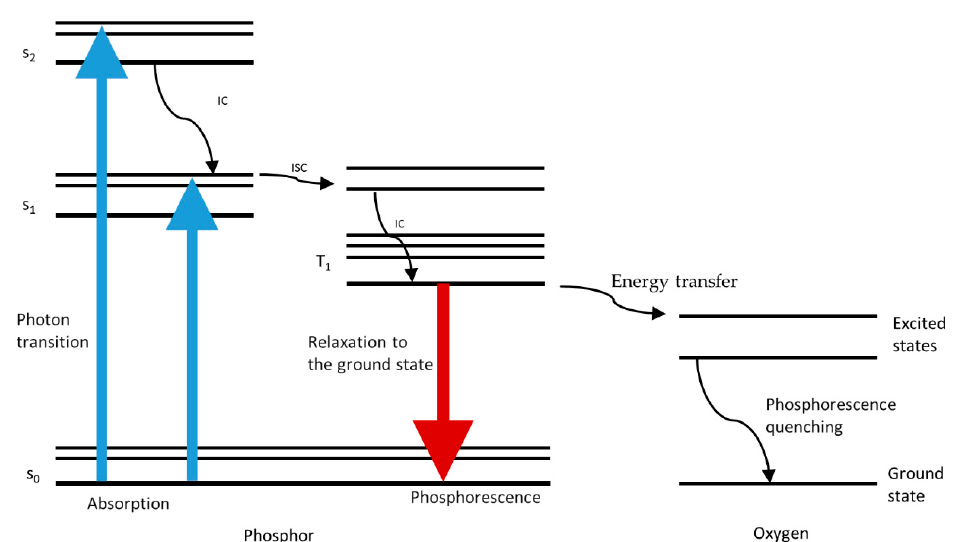
Figure A1. Simplified Jablonski diagram shows phosphorescent generation and main energy transitions during measurement. S 0 : Ground state of the phosphor; S 1 : First excited singlet states of the phosphor; S 2 : Second excited singlet states of the phosphor; T 1 : The excited triplet state of the phosphor; IC: Internal Conversion; ISC: Inter-system Crossing.